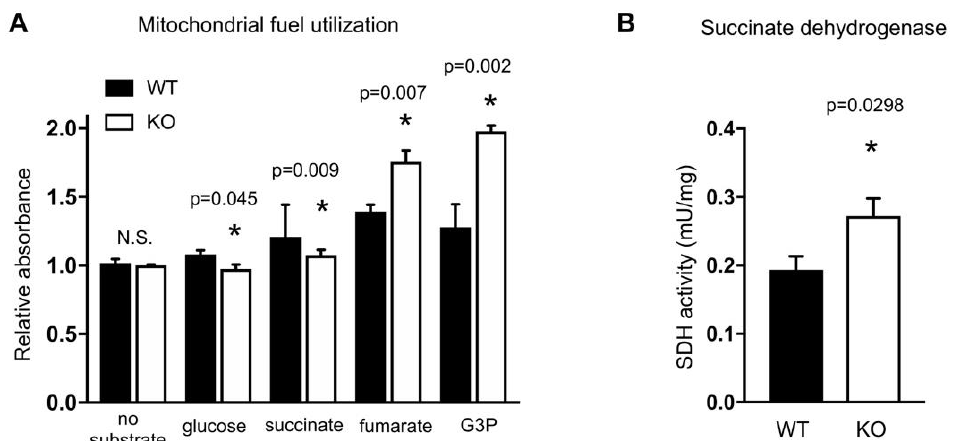
Figure 3. HO-1 knockout cells have altered mitochondrial fuel utilization. ( A ), Utilization of glycolytic and TCA cycle metabolites by WT and KO mitochondria was determined using the Biolog MitoPlate. ( B ), Succinate dehydrogenase activity was determined for WT and KO cells. * p < 0.05 vs. WT. Error bars are SEM.